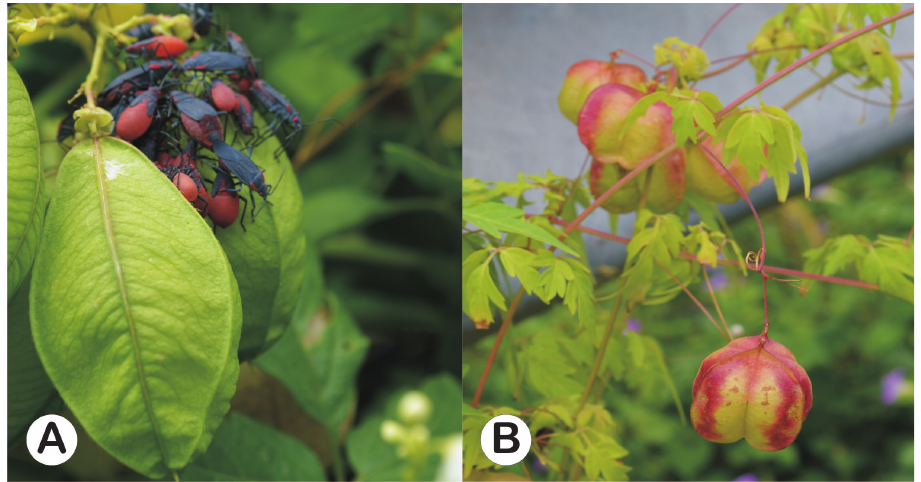
Figure 2. Cardiospermum fruit. The ornamental attraction of Cardiospermum plants and the reason for their widespread distribution is their balloon shaped fruit A C. grandiflorum (JJ Le Roux) and B C. hali- cacabum (JJ Le